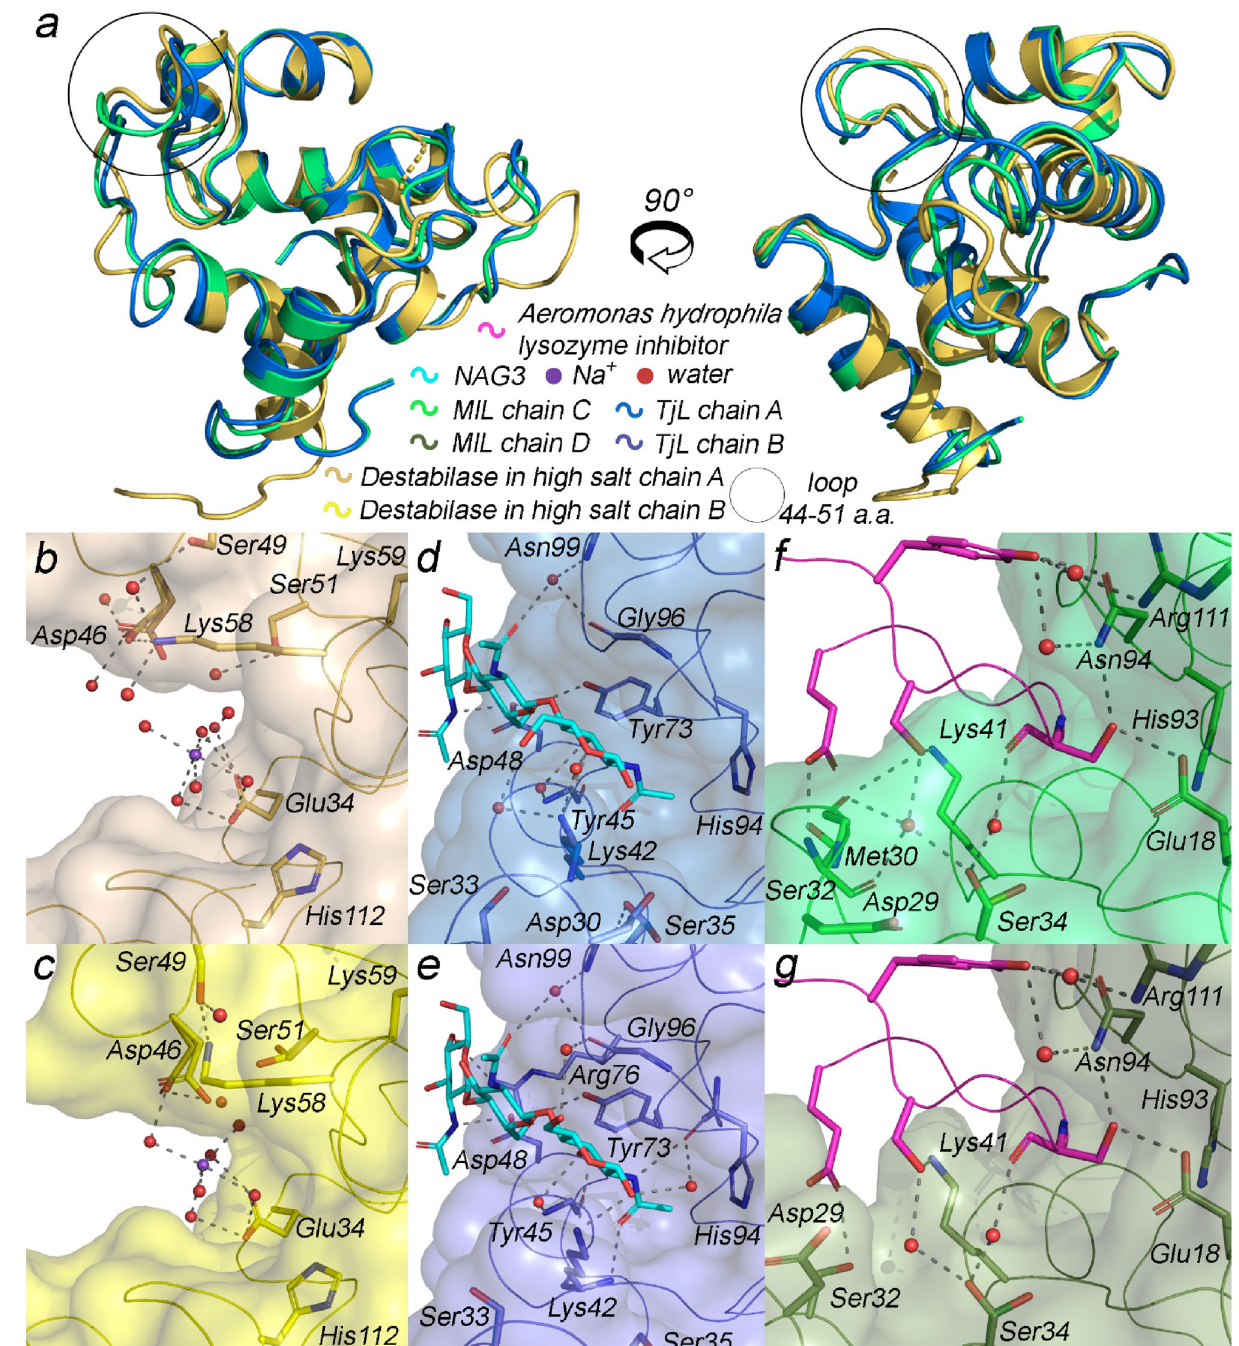
Figure 3. High salt destabilase structure and of its homologs. ( a ) Overall structure superposition of high salt destabilase chain A, TjL chain A (PDB ID 2DQA 23 ) and MlL chain C (PDB ID 4PJ2 24 ); lateral view on the inhibited enzymatic centers of high salt destabilase (( b,c ) for chains A, B, correspondingly), TjL (( d,e ) for chains A, B, correspondingly) and MlL (( f,g ) for chains C, D, correspondingly). Residues potentially responsible for muramidase and isopeptidase activities or bonded to the inhibitor through the water molecules are shown as sticks. Inhibitors of muramidase activity are depicted as spheres, sticks or ribbon diagrams, respectively: ( b,c ) water coordinated Na + ion; ( d,e ) NAG3; ( f,g ) Aeromonas hydrophila lysozyme inhibitor. Water and inhibitory molecules as well as hydrogen bonds are shown for alternative conformation A only in MlL and TjL structures and for alternative conformations with presence of sodium in destabilase structures. The variability of an inhibitor-bound TjL and MlL loop 44–51 confirms the importance of the loop flexibility for enzymatic activities of the